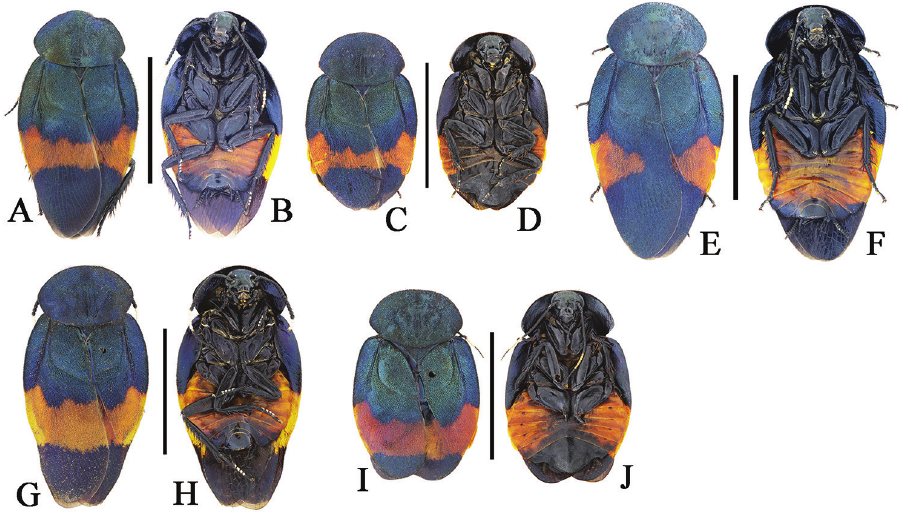
Figure 4. A–J Eucorydia dasytoides from Hainan and Taiwan A–D the zonata population from Taoyuan, Taiwan: A–B male C–D female E–F the taitoensis population, male, from Taidong, Taiwan G–J the Hainan population from Mt. Jianfengling: G–H male I–J female. Scale bars 10